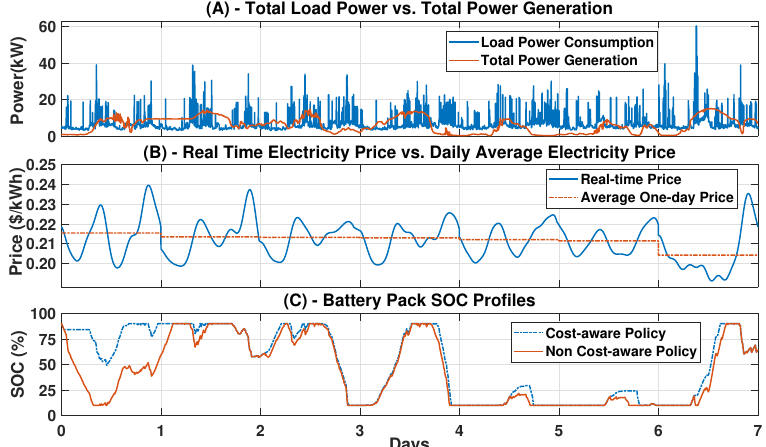
Figure 9. Different scenarios of two power management policies within one example week.